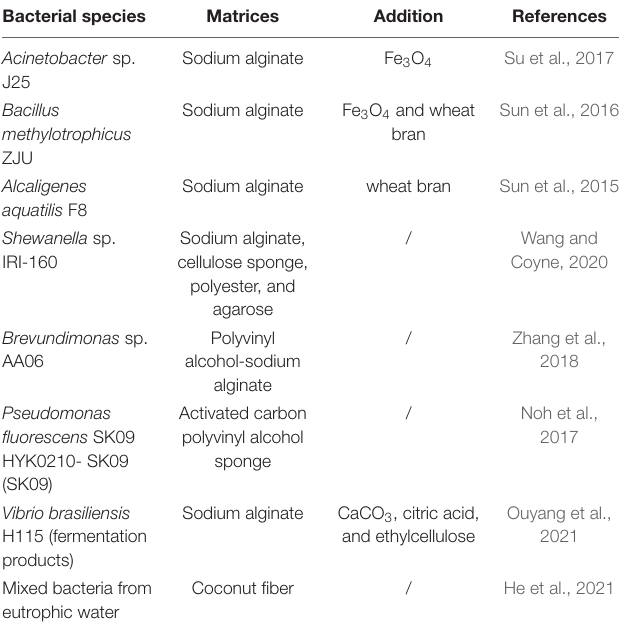
TABLE 3 | Select recent studies on immobilization of algicidal